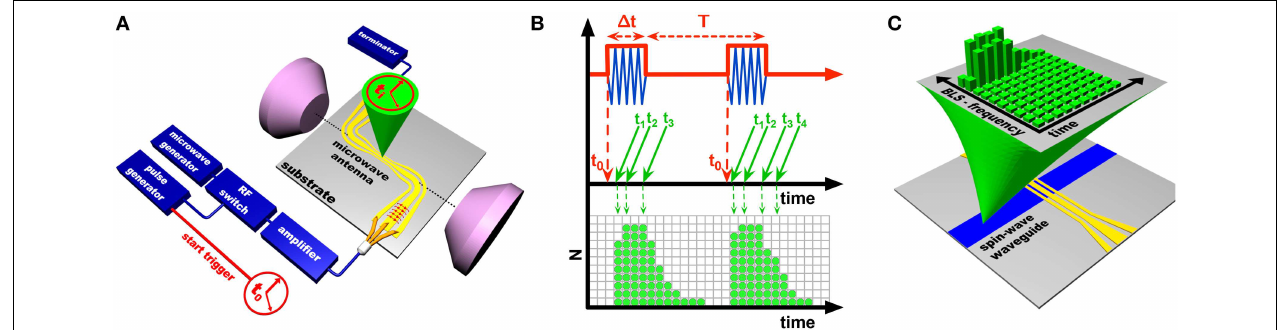
FIGURE 14 | (A) Typical setup for a time-resolved BLS experiment and (B) measurement scheme. Microwave pulses generate a dynamic magnetic field